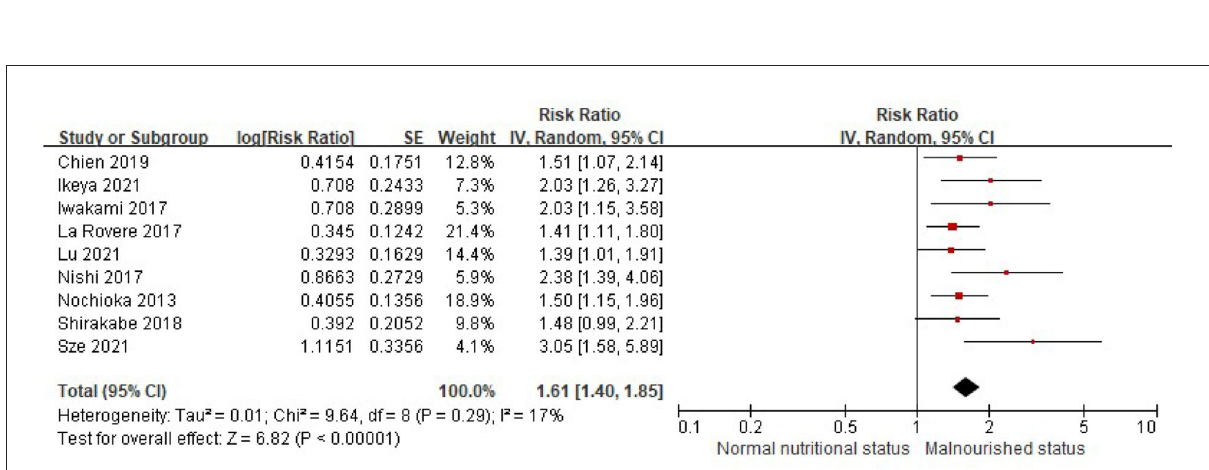
FIGURE3 A forest plot of comparison: All-cause mortality in patients with HF associated with malnutrition status defined by the CONUT score. CONUT, controlling nutritional status; HF, heart